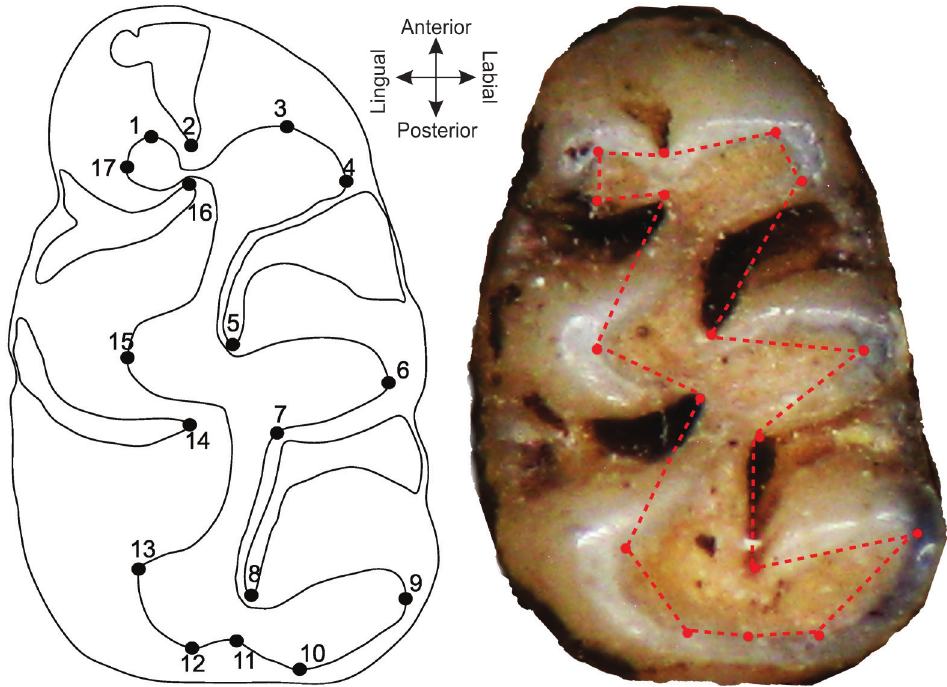
Figure 2. Landmarks of the molar used in this study. For landmarks description, see text.